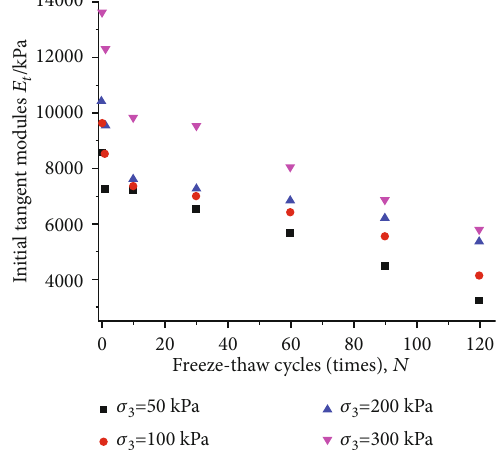
Figure 4: The changing law of the initial tangent modulus E di ff erent